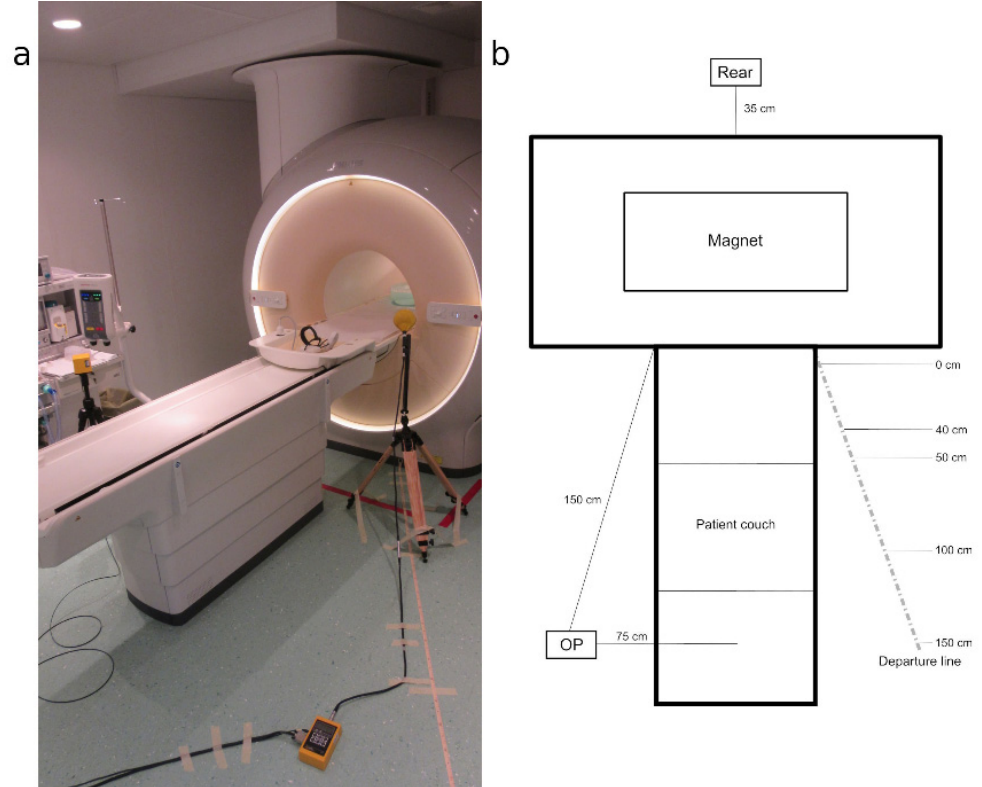
Figure 1. Position of the measuring points: the “OP” and “REAR” points and the measuring points along: ( a ) Real setup; ( b ) Explanatory scheme. Table 3. Tomographs and GMF diagnostic sequences analysed; the “Code” column shows the reference with which the sequences are indicated in the result